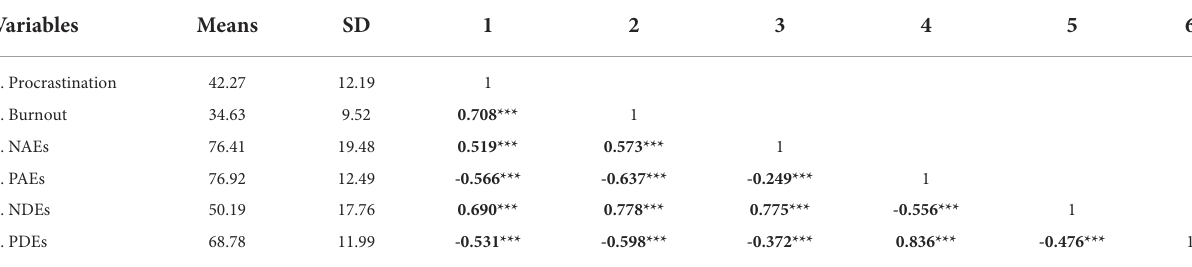
TABLE 3 Means, SD and correlations of continuous